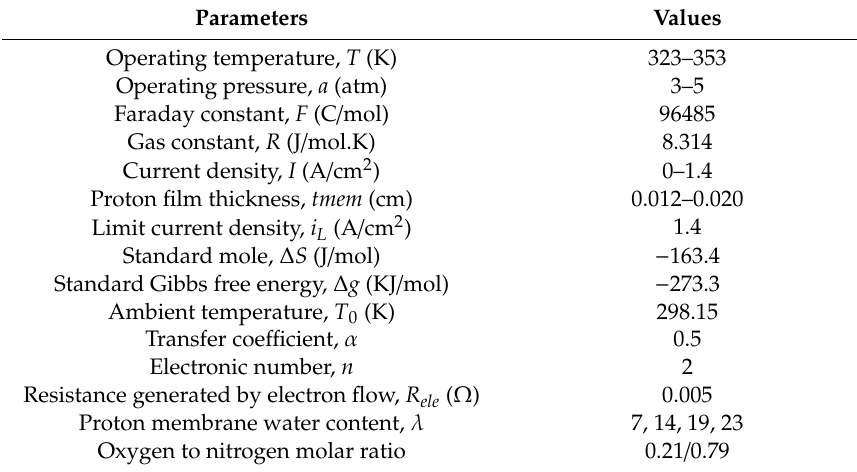
Table 1. Model parameters of irreversible